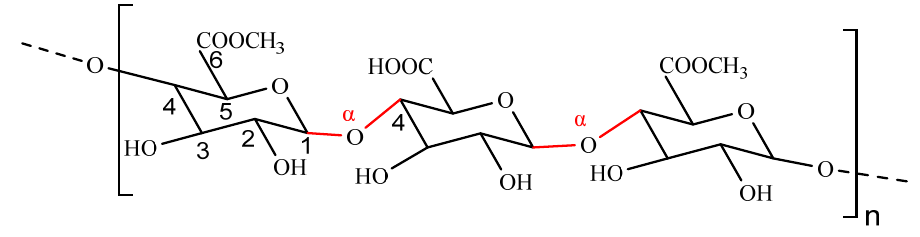
Figure 4. The structure of pectin.